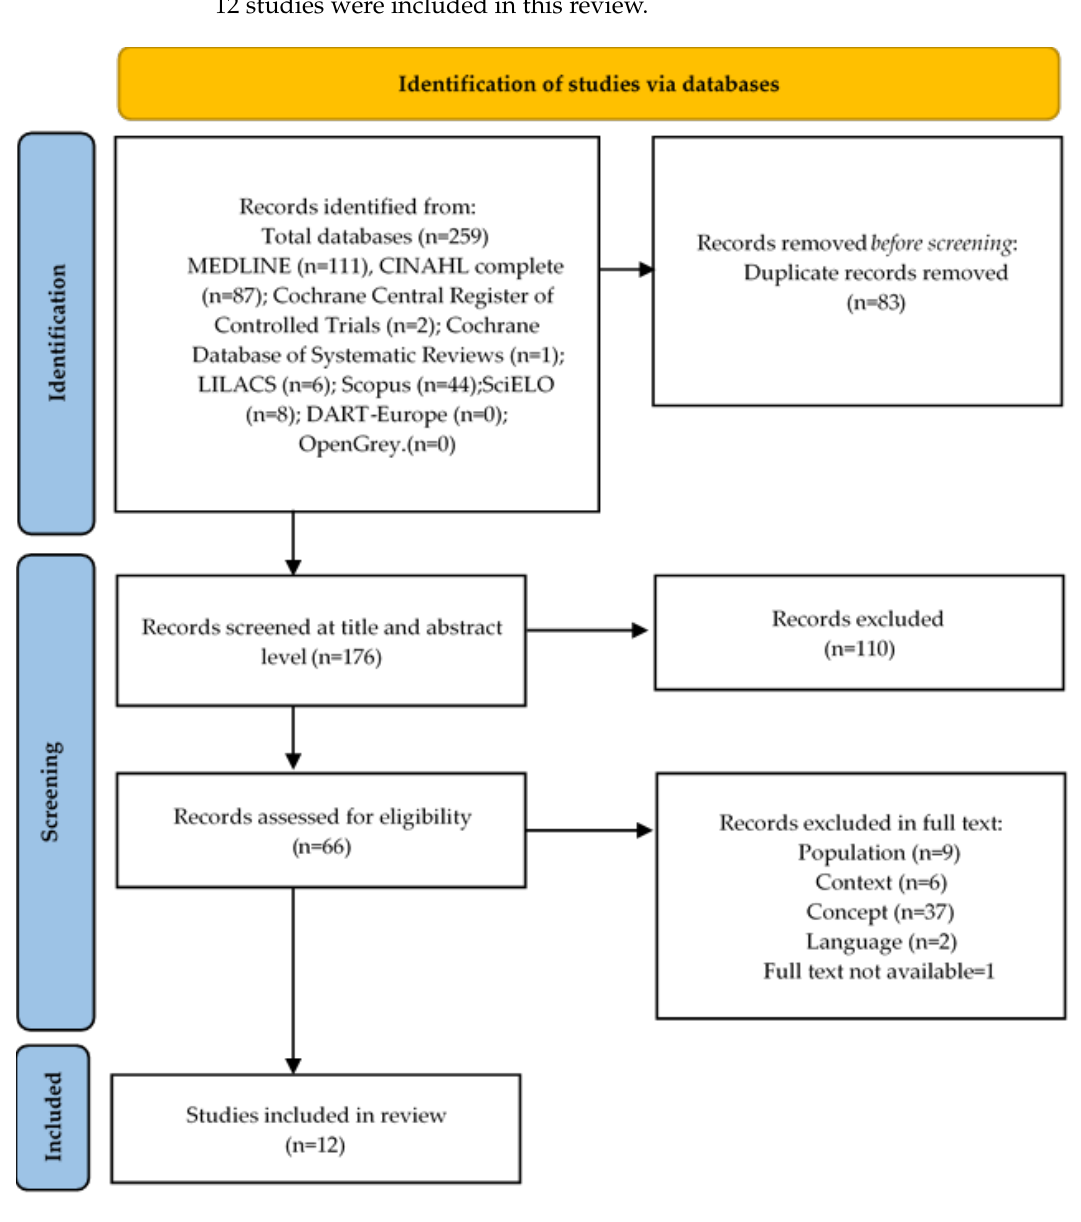
Figure 1. PRISMA Flowchart.